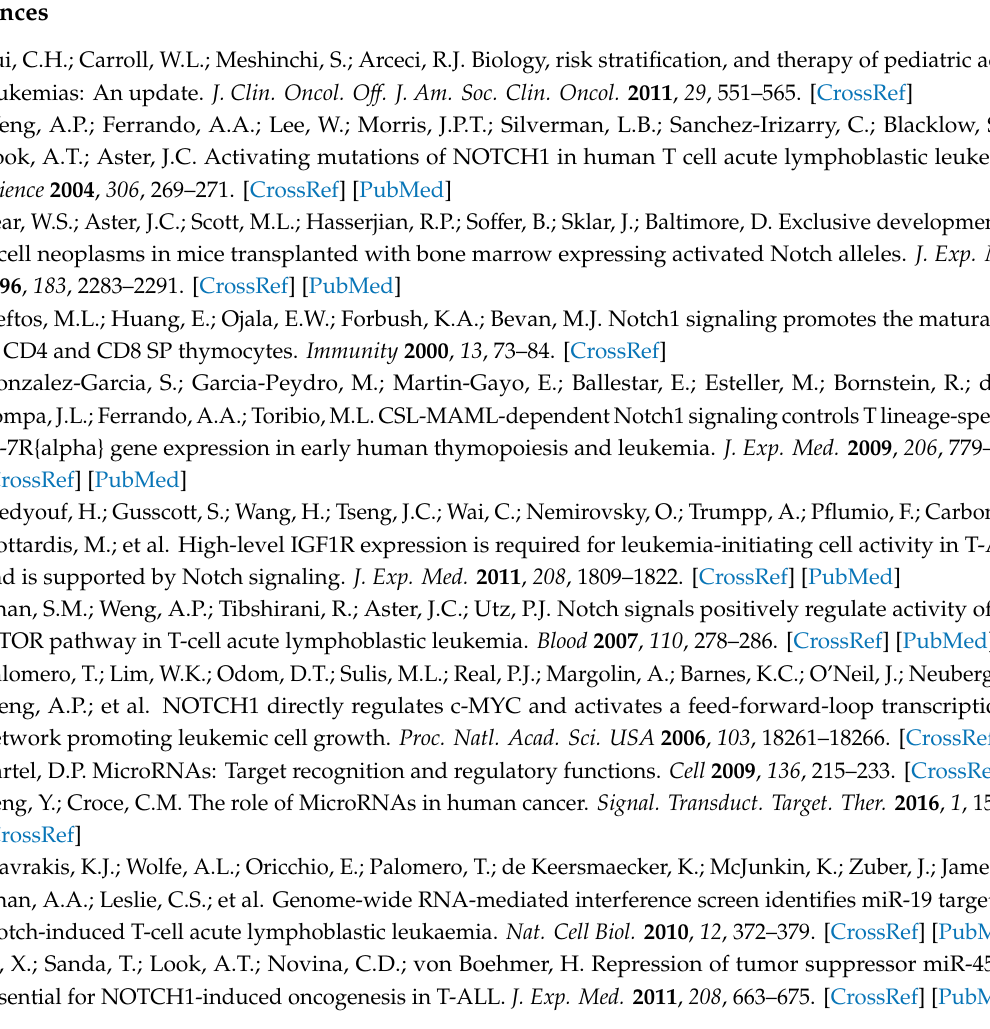
Figure S1: E ff ect of NOTCH1 inhibition on miR-29a-3p expression in human T-ALL cell lines, Figure S2: E ff ect of NOTCH1 inhibition on ICN1 and Dtx1 expression, Figure S3: miR-22-3p overexpression in Jurkat-E6 cells delays tumor growth in vivo, Table S1: Hallmark gene sets deregulated following GSI treatment in NOTCH1-induced T-ALL in vivo, Table S2: Di ff erentially expressed miRNAs in DBZ- vs DMSO-treated samples, Table S3: NOTCH1 and FBXW7 mutational status in T-ALL PDX samples, Table S4: Genes contributing to the negative enrichment of the ‘GO_ALPHA_BETA_T_CELL_PROLIFERATION’ gene set in MOLT4 overexpressing